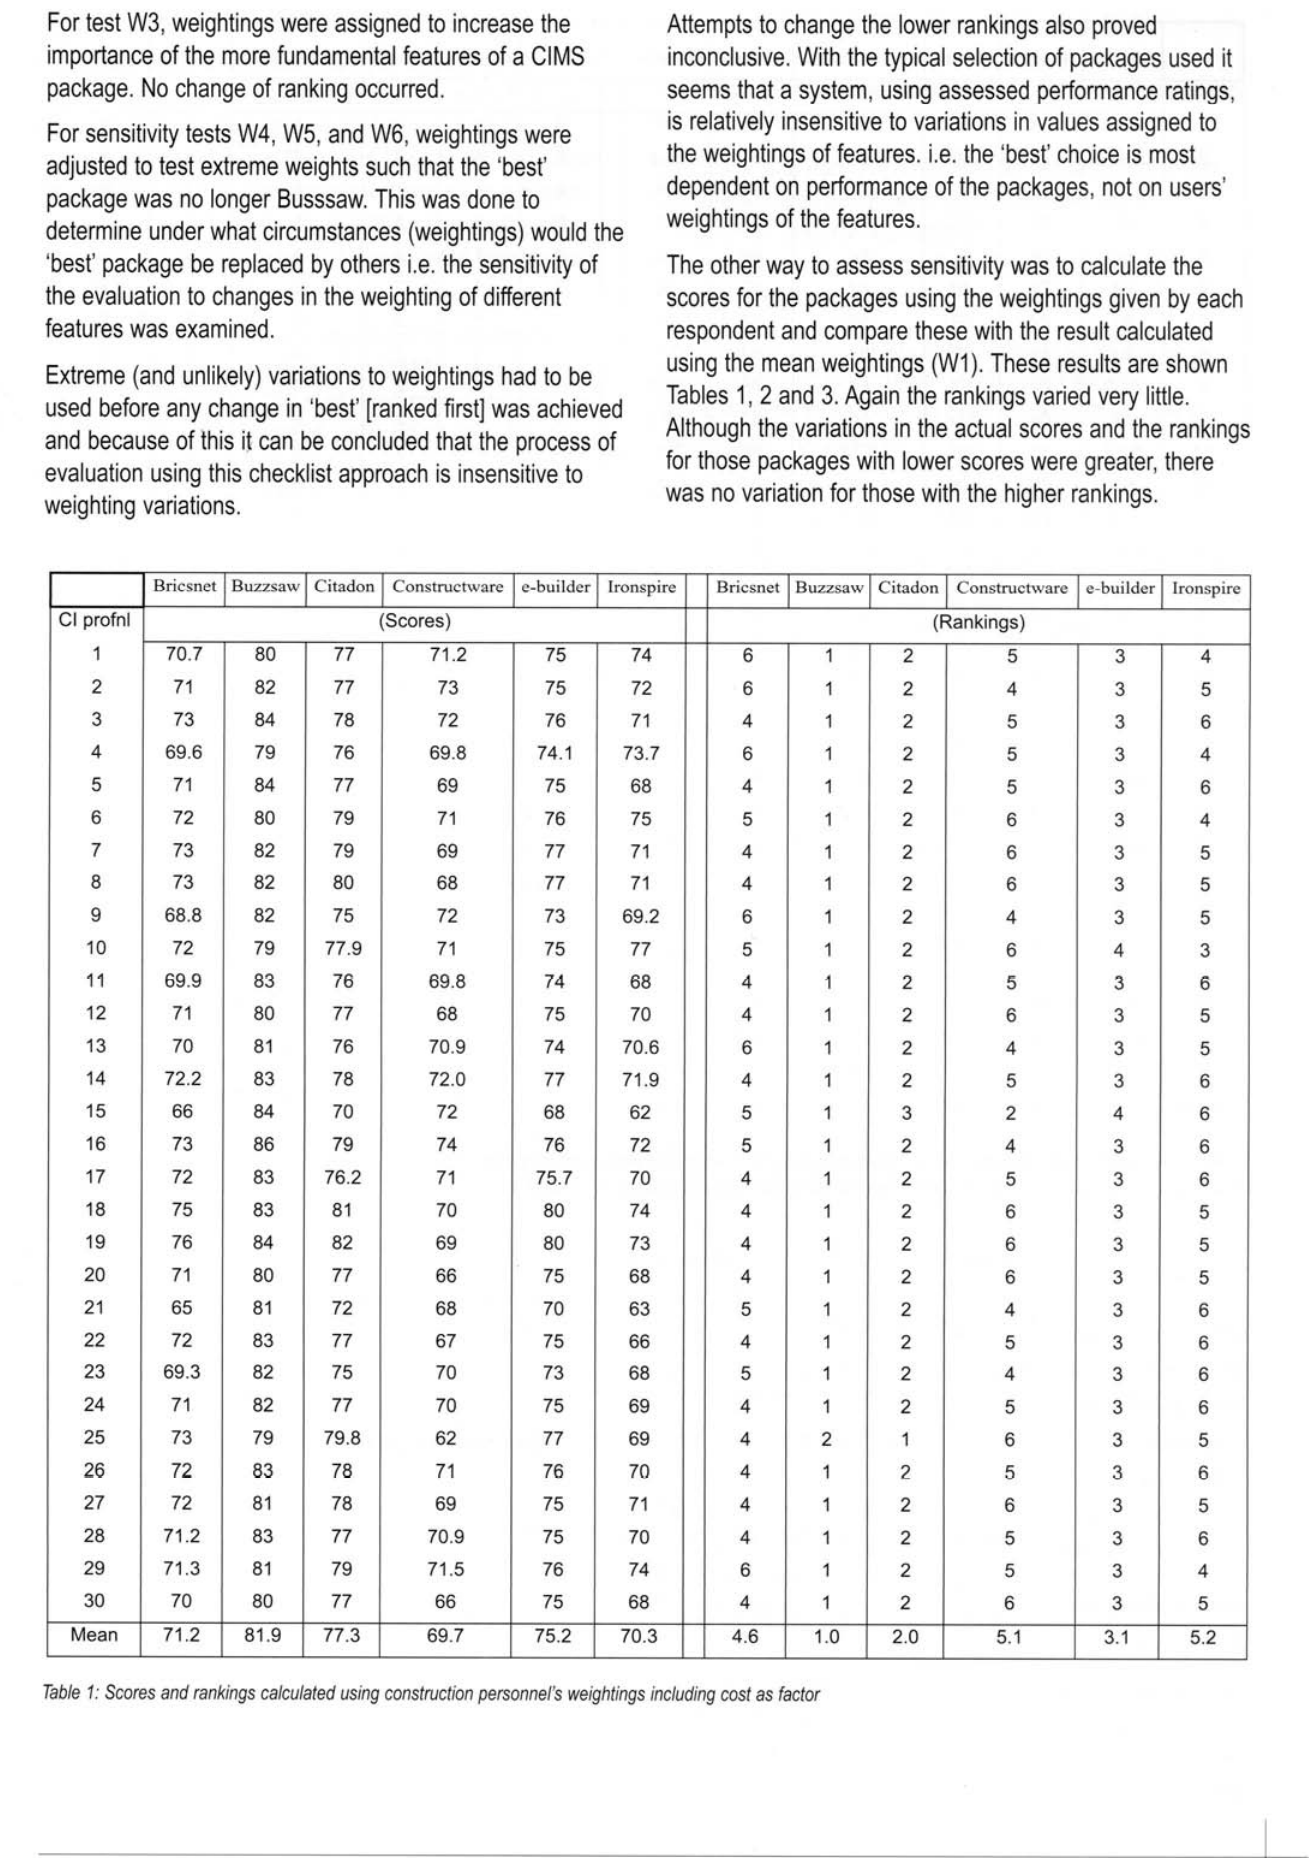
Table 1: Scores and rankings calculated using construction personnel's weightings including cost as